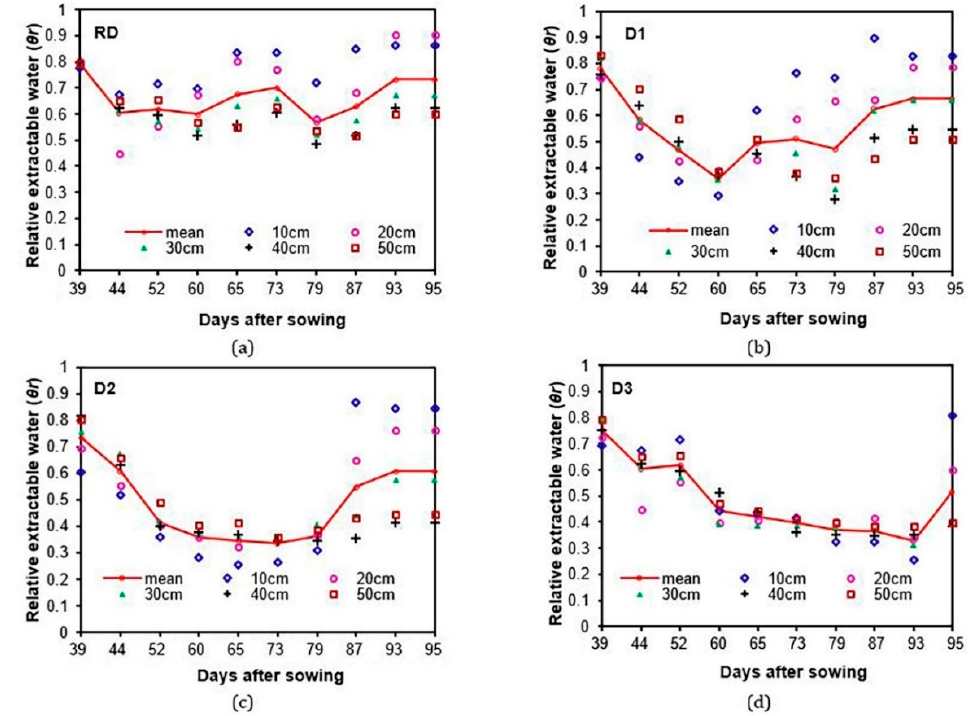
Figure 2. Variations of soil relative extractable water θ r under different drought scenarios. ( a ) RD (no drought), ( b ) D1 (drought between June 30–July 27), ( c ) D2 (drought between June 30–August 10), and ( d ) D3 (drought between July 15–August 24).